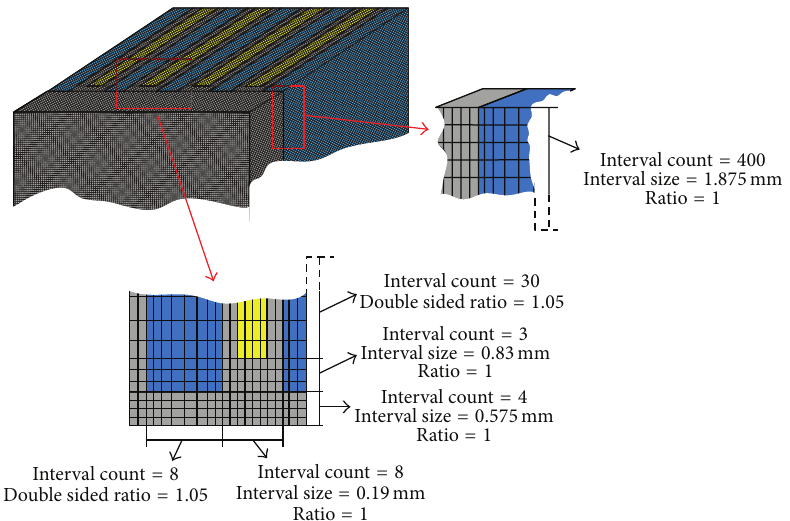
Figure 7: Mesh configuration of standard fuel assembly.